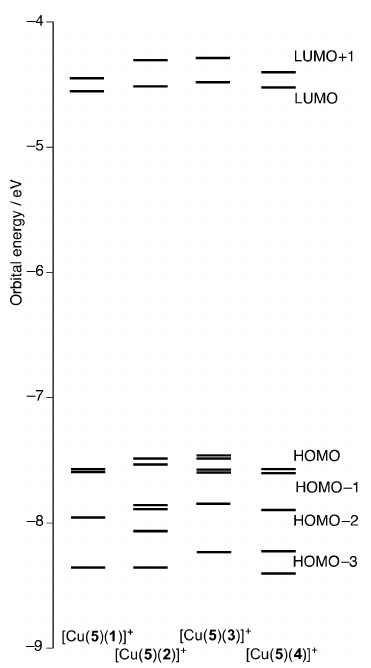
Figure 11. Orbital energies carried at DFT B3LYP level with a 6-31G* basis set in vacuum for [Cu( 5 )( 1 )] + , [Cu( 5 )( 2 )] + , [Cu( 5 )( 3 )] + , and [Cu( 5 )( 4 )] +